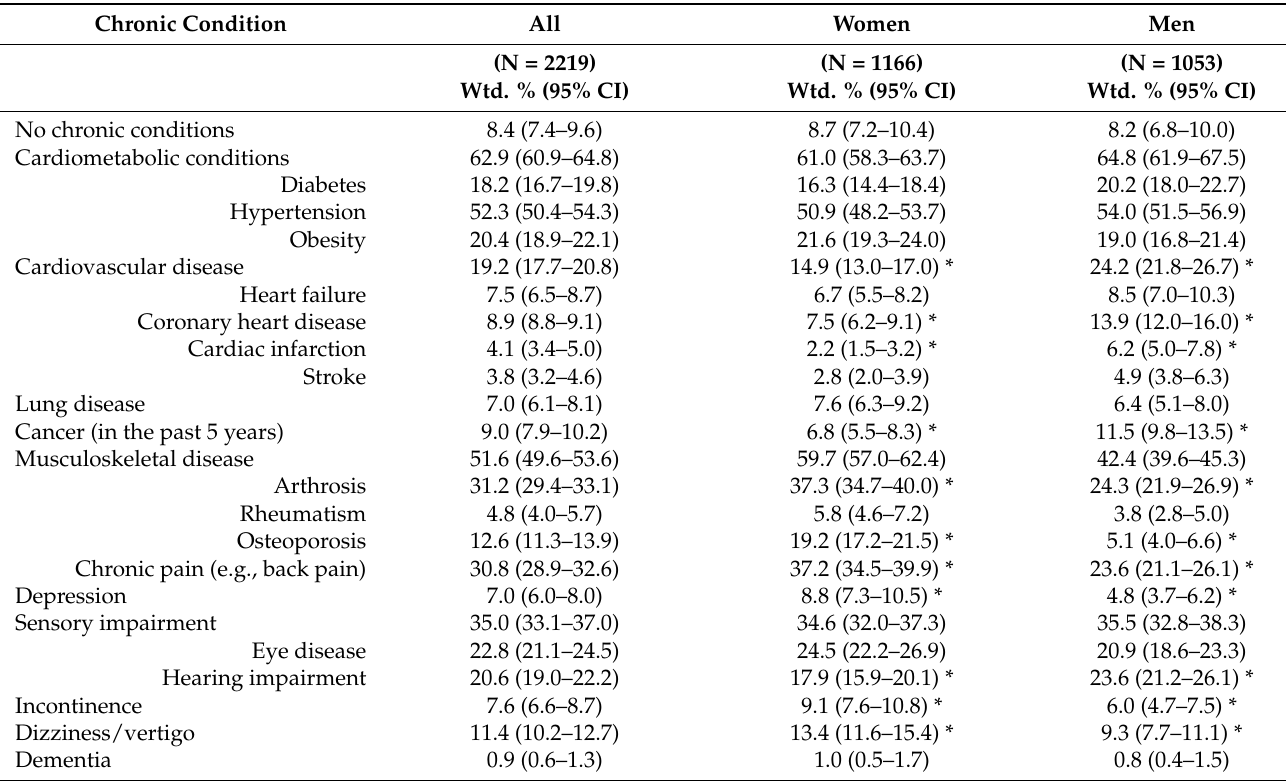
Wtd.% = weighted %; CI = confidence intervals. Cell percentages are based on weighted data for everyone in that age group. N at top of each column is the unweighted number of respondents in that group. * Statistically significant difference (95% CIs do not